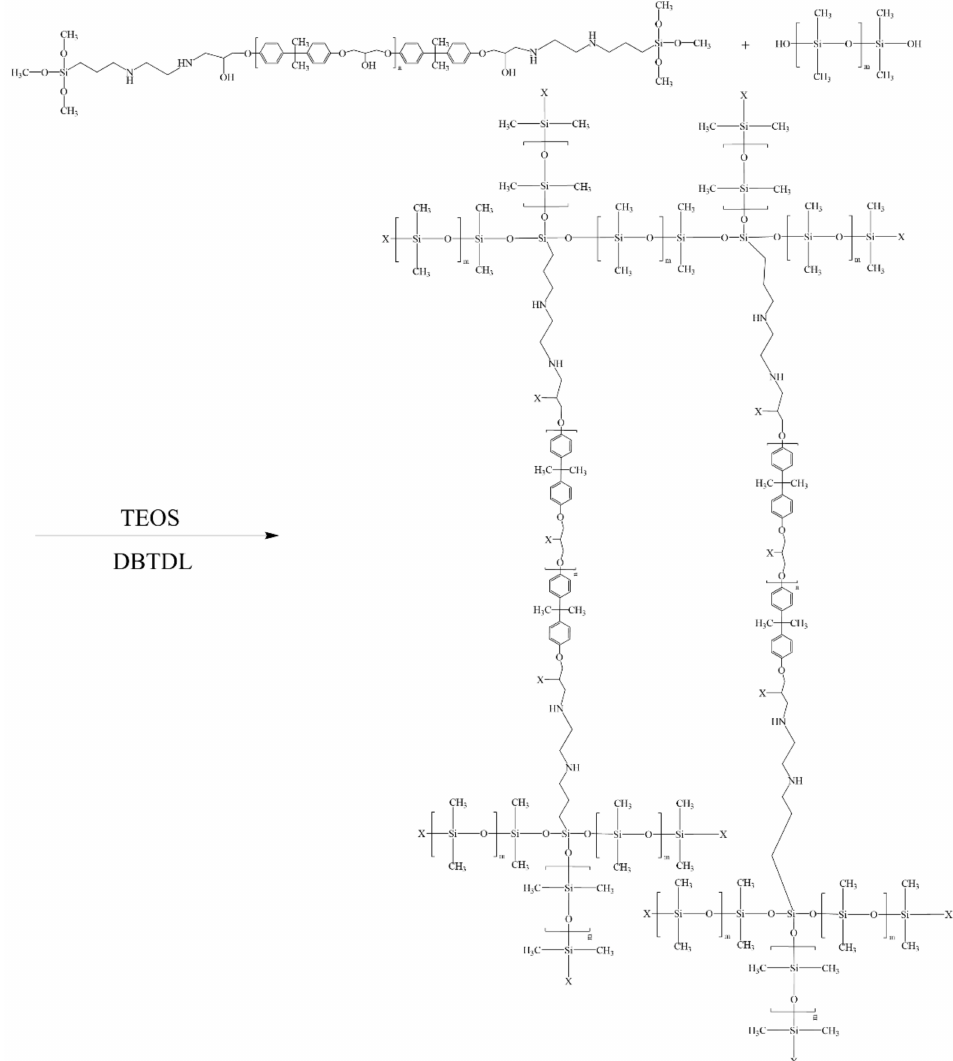
Figure 12. The cross-linking reaction principle of the modified silicone